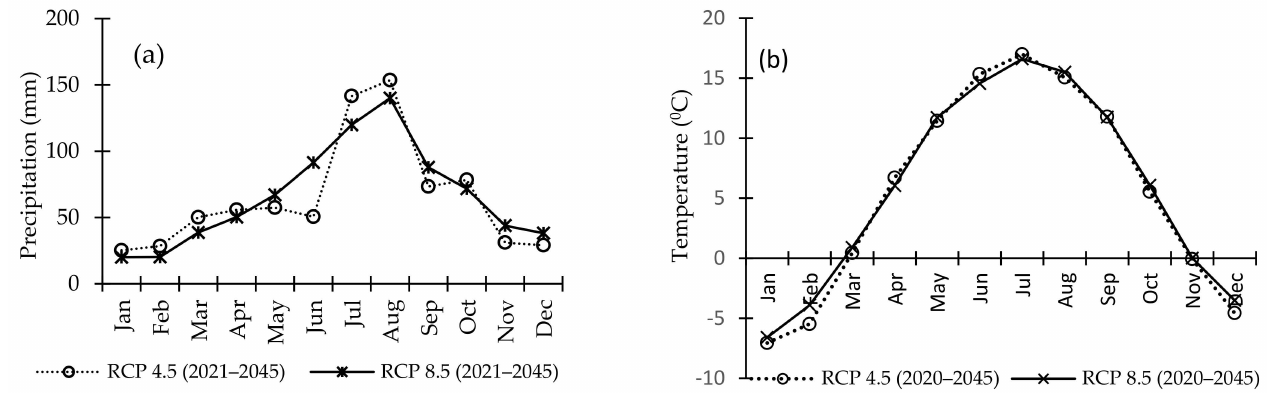
Figure 6. Monthly mean of ( a ) precipitation and ( b ) temperature for the future period (2020–2045) periods used in the SWAT